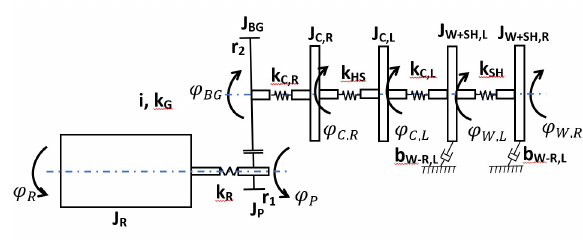
Figure 7. Wheel slip deduction [2].